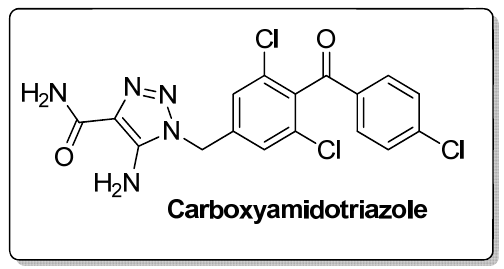
Figure 7. A 1,2,3-triazole-containing clinical drug. Figure 7. A 1,2,3 ‐ triazole ‐ containing clinical drug.